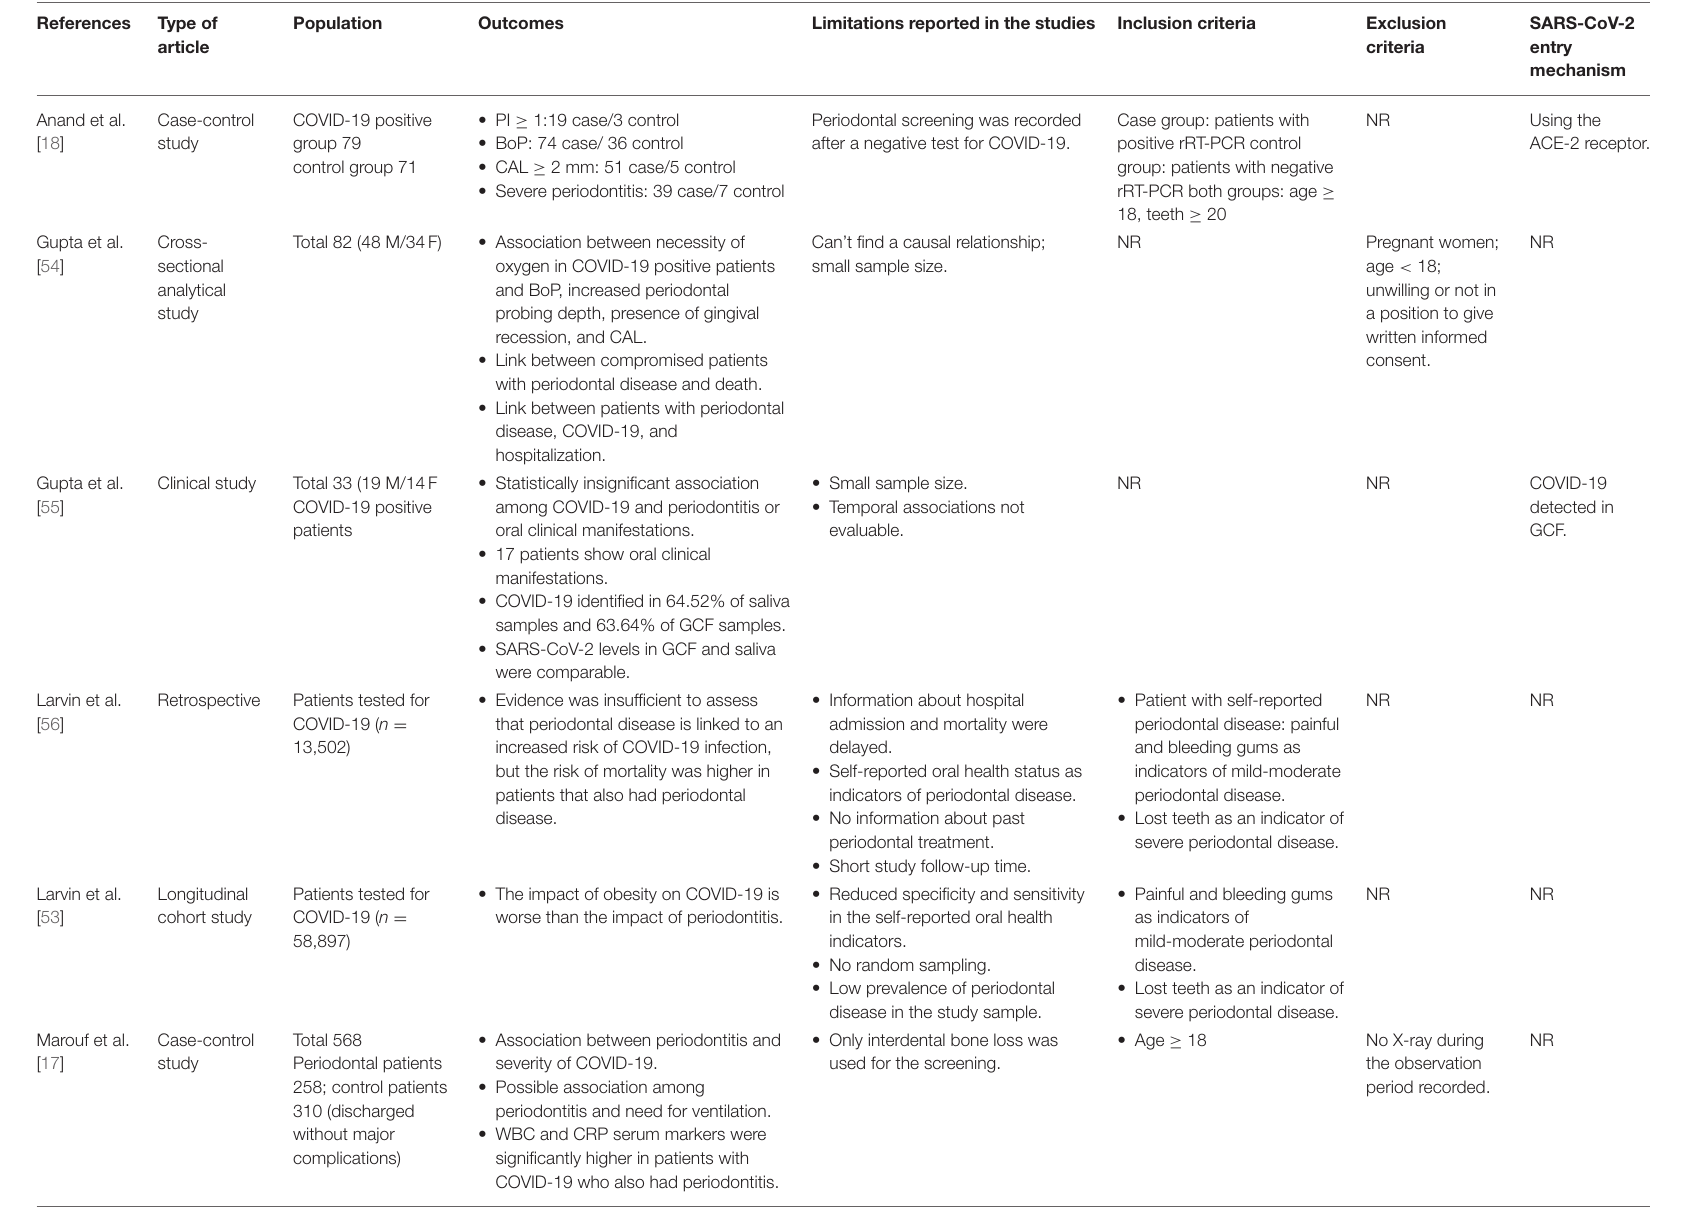
TABLE 1 | Clinical studies included in the review, data regarding type of study, population outcome, and details for the possible correlations are